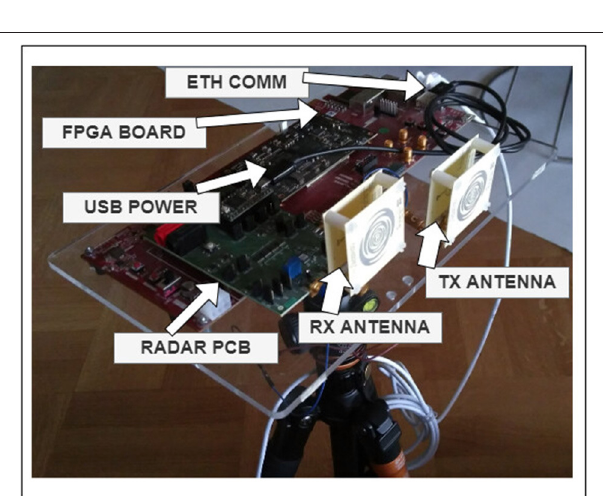
FIGURE 8 | The lab prototype test platform on which the 8 GHz UWB FMCW radar IoT sensor IC is mounted for collecting data and carrying out measurements for vital-sign monitoring, activity classification, and other indoor